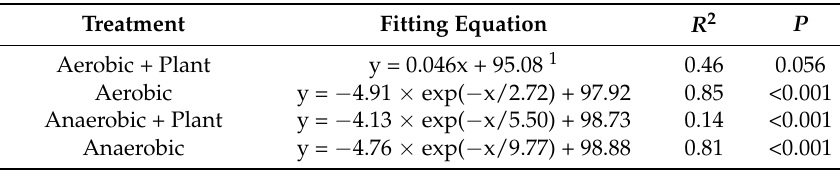
Table 4. Fitting equations of TP removal when Fe:P = 10.